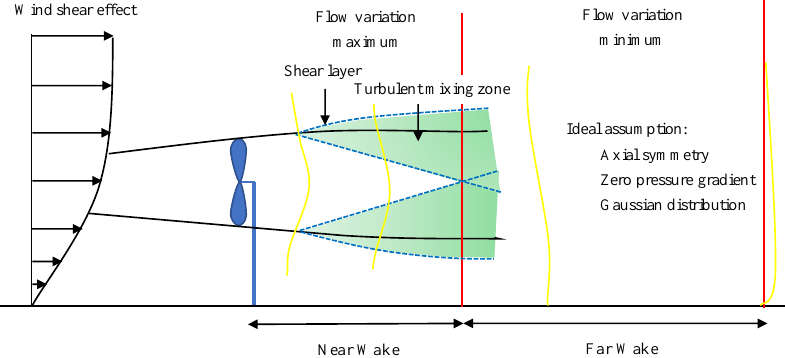
Figure 1. Ideal hypothesis and regional distribution of wind turbine wakes.